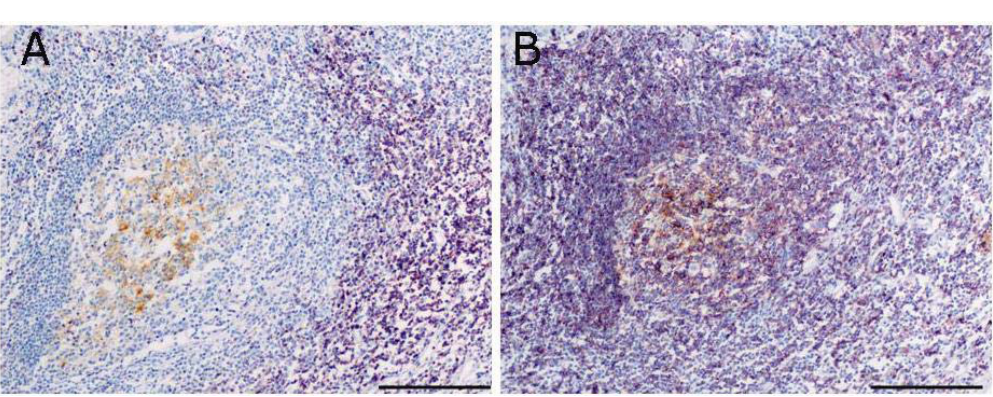
Figure 2. Immunohistochemistry of tertiary lymphoid tissue in sections of human colo-rectal tumors. T cells (purple, A ) and CD20 + B cells (purple, B ) surround CD21 + follicular dendritic cells (brown, A – C ); Sections in A and B are consecutive sections and show the compartmentalization between B and T cells in the follicle. Mature dendritic cells are also present, as evidenced by DC-LAMP staining ( D ). Scale bar = 100 μ